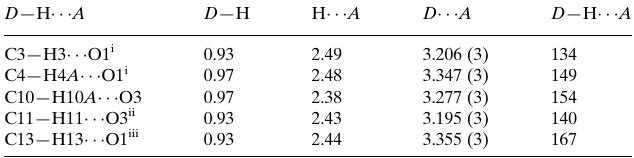
Hydrogen-bond geometry (A˚ , (cid:2)